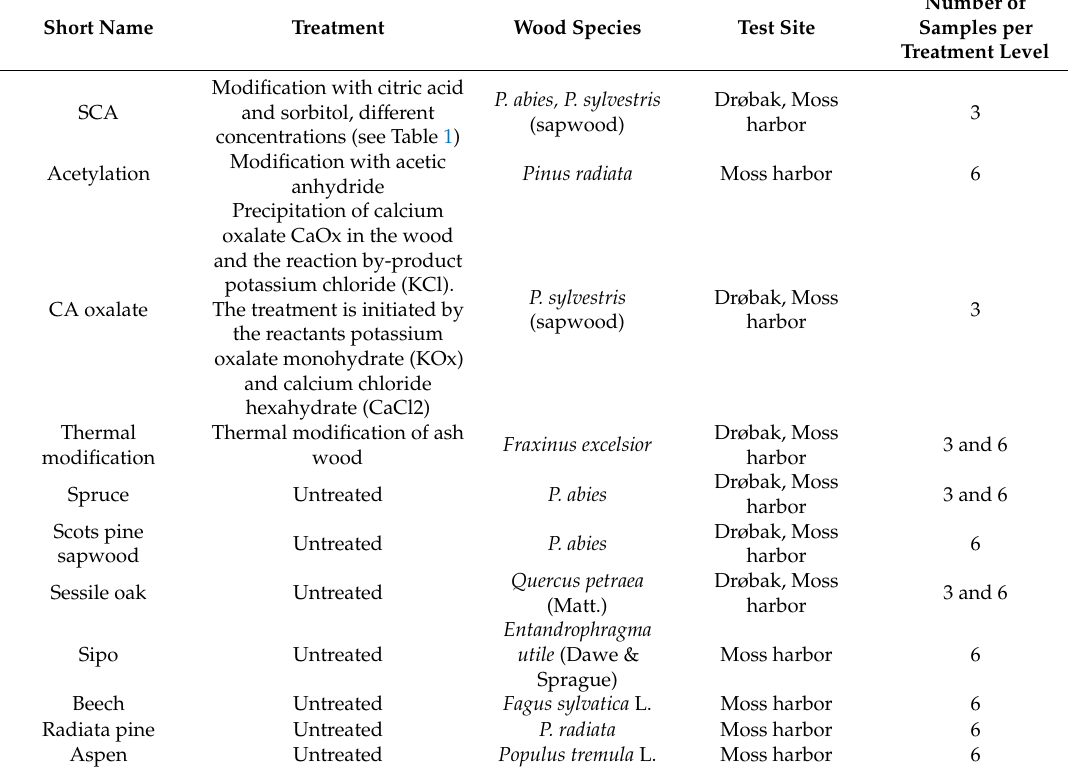
Table 2. Overview of treatments tested in the marine